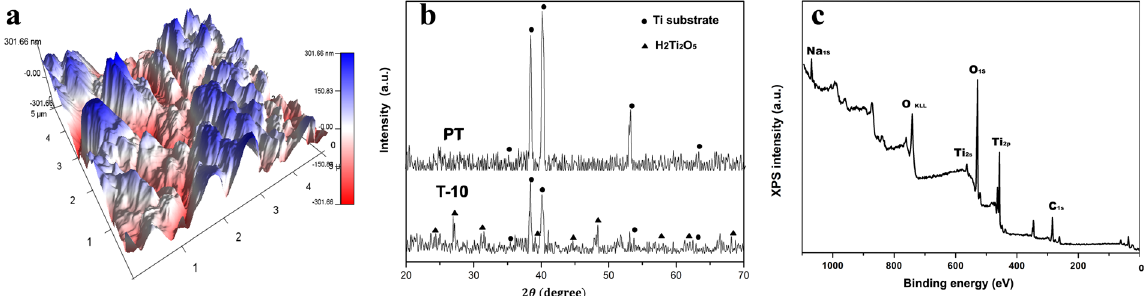
Figure 3. Surface roughness and composition of T-10 sample treated at 120 °C in 10 M NaOH solution for 4 h: ( a ) AFM micrograph, ( b ) X-ray diffraction patterns and ( c ) wide-range survey scan of XPS spectrum.